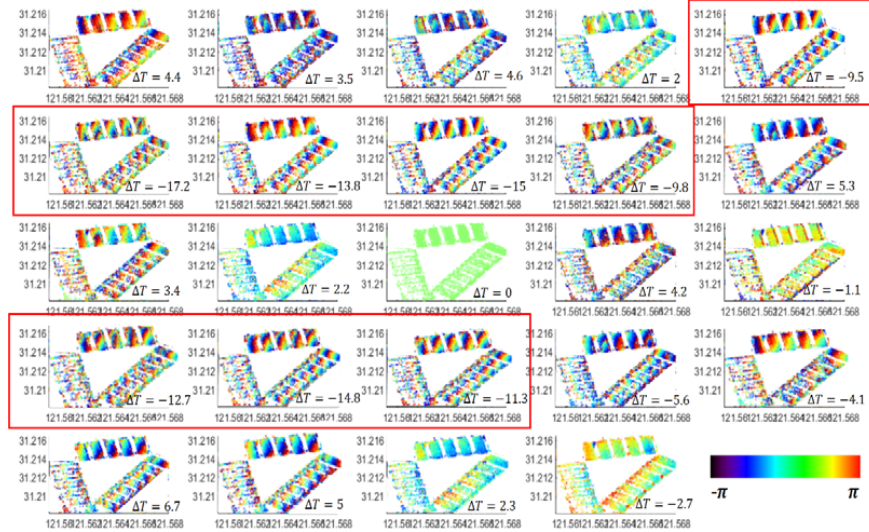
Figure 9. The time series differential interferograms of the SNIEC, the red rectangles indicate the differential interferograms with larger temperature differences and denser fringes.